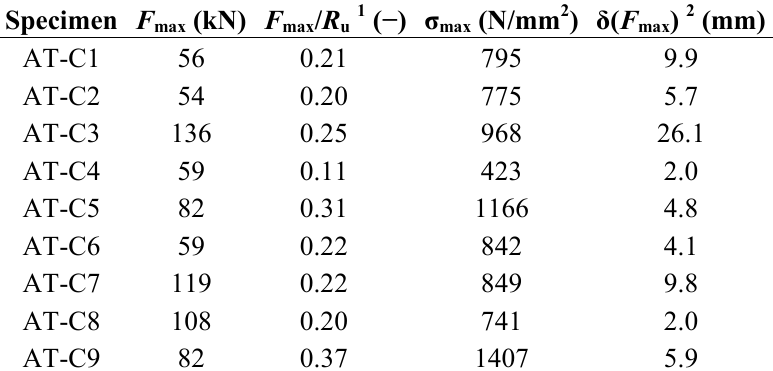
Table 10. Results of Series